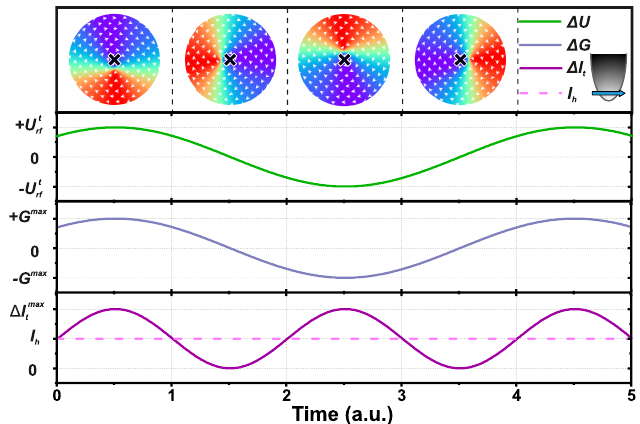
Figure 1. Sketch of the time evolution of the vortex gyration, the rf voltage U t conductance, and the resulting supplementary tunneling current excited at resonance and at a phase difference φ = 0.